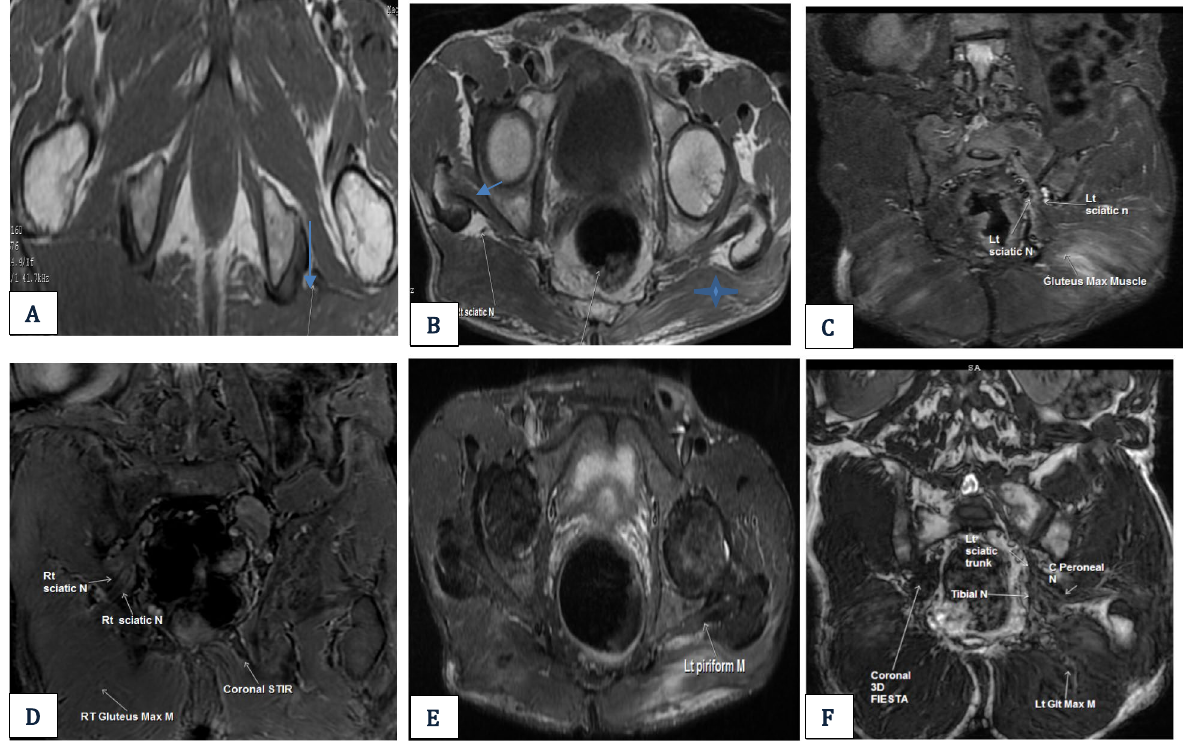
Fig. 5 A 24‑year‑old female patient, having a history of intermittent left lower limb pain and cramps. Electrophysiological studies revealed prolonged F wave latency, with ve ipsilateral straight leg raising test; MRI of the pelvis shows a relatively reduced left gluteus maximum muscle + bulk (marks in B ) and left sciatic nerve arrowed in ( A ). MRN shows high signals in the fore‑mentioned muscle as well and high bifurcation of the left sciatic nerve at the upper border of left piriformis muscle with relatively increased thickness and signal intensity ( C–F ), denoting a left piriformis